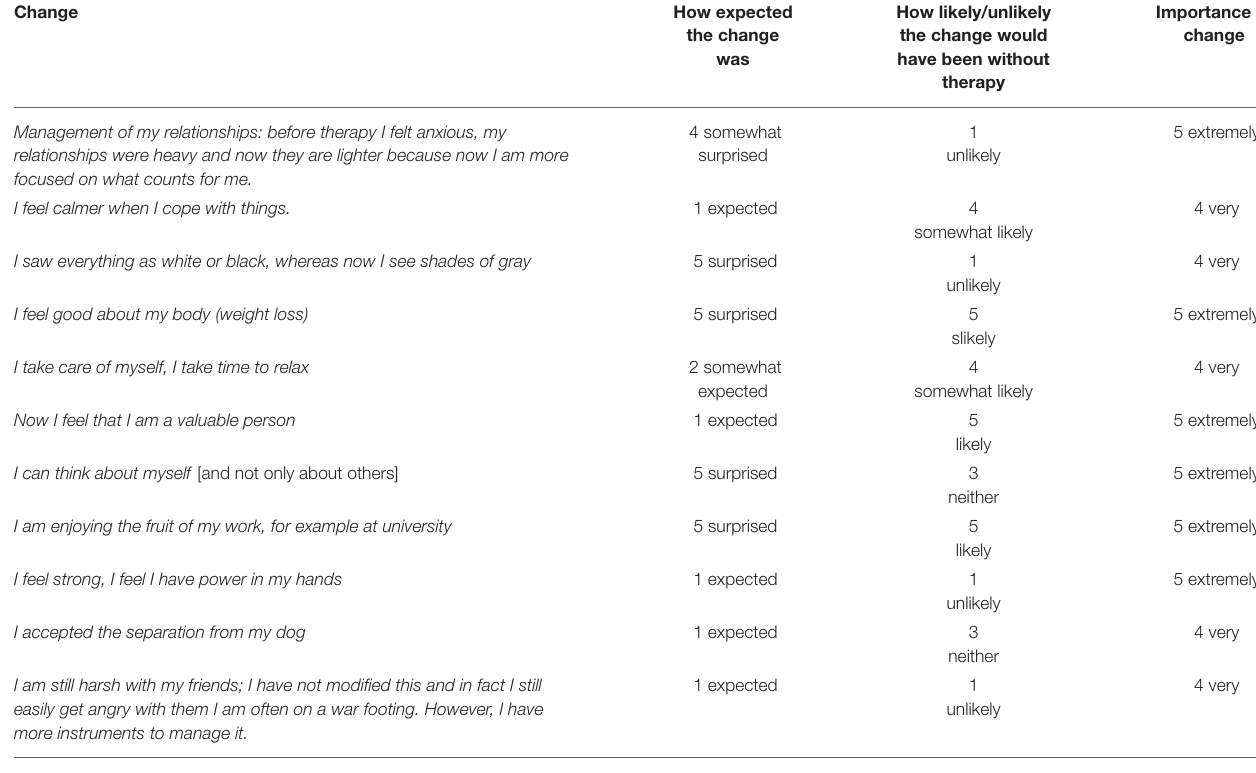
TABLE 2 | Summary change interview of Maria. Change How expected